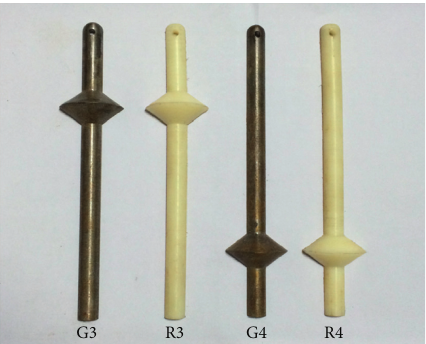
Figure 3: Model of rigid and flexible concrete expanded